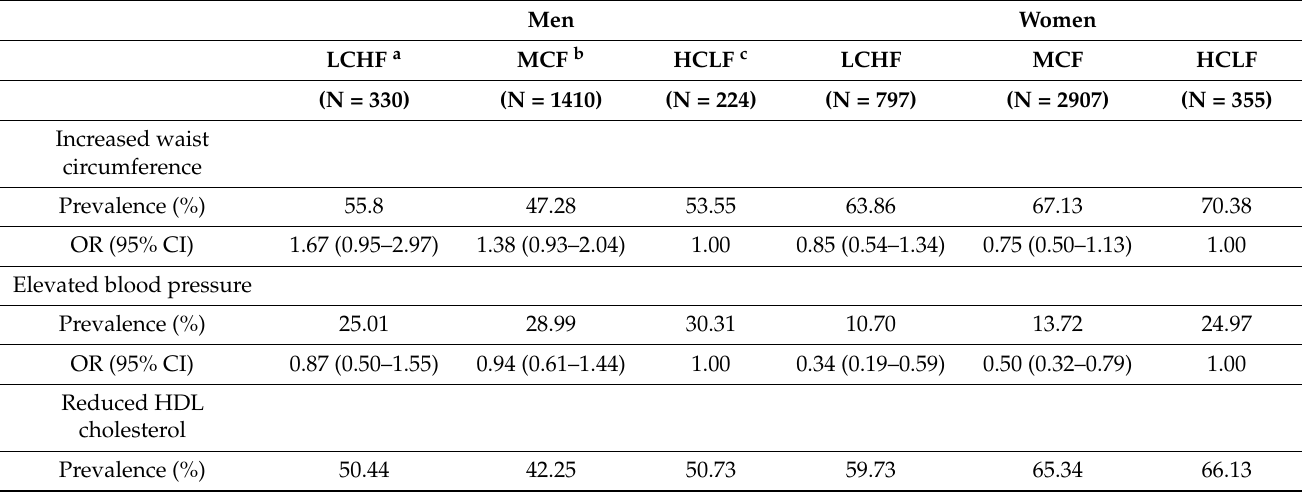
Table 3. Prevalence and multivariable-adjusted odds ratios for MetS among participants according to carbohydrate and fat